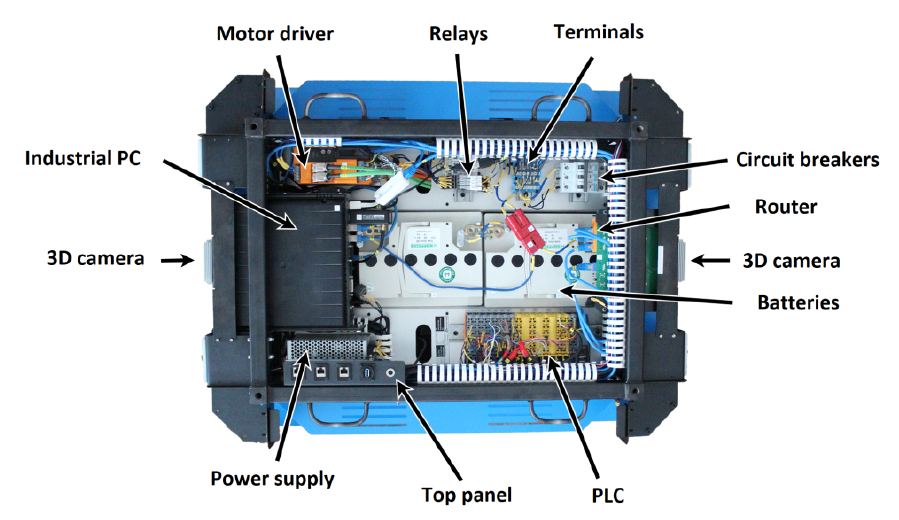
Figure 3. Positions of built-in electrical components.